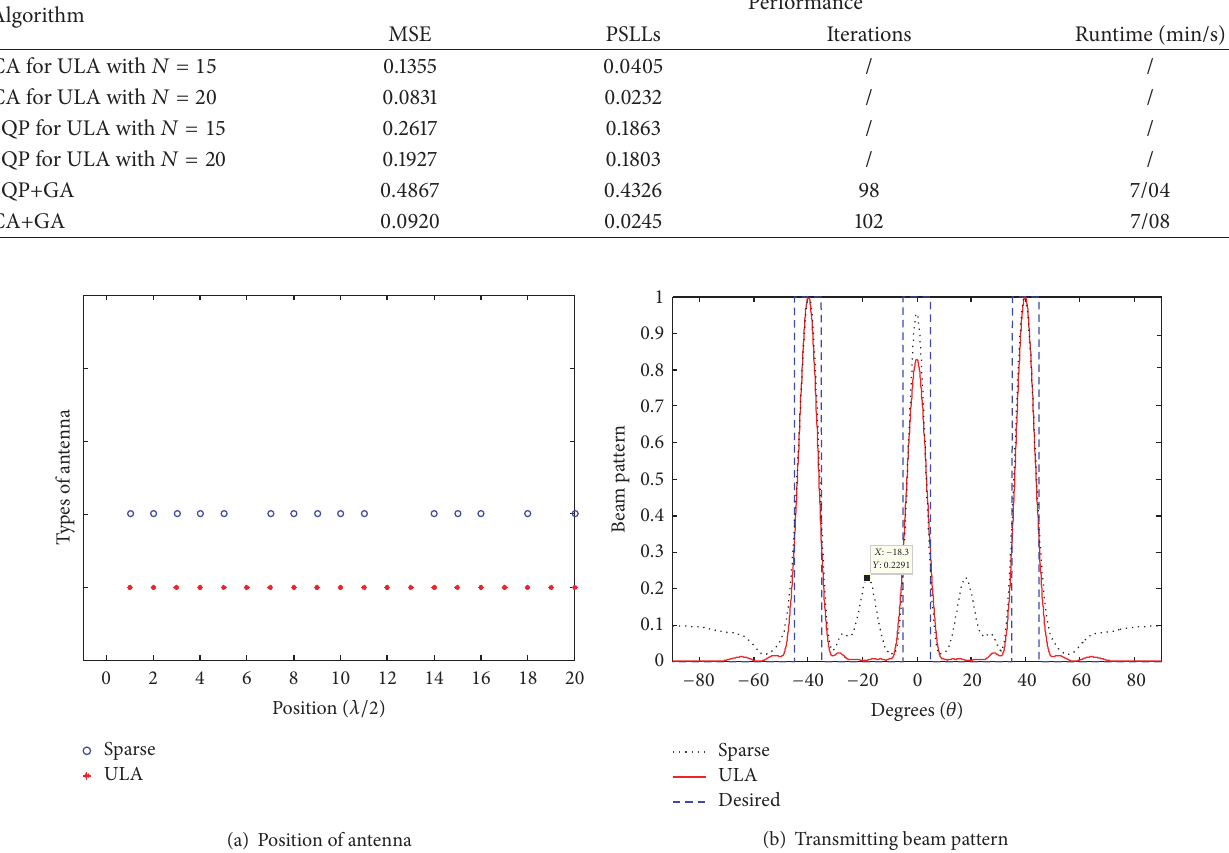
Figure 4: Results of DE with mutation strategy 1.